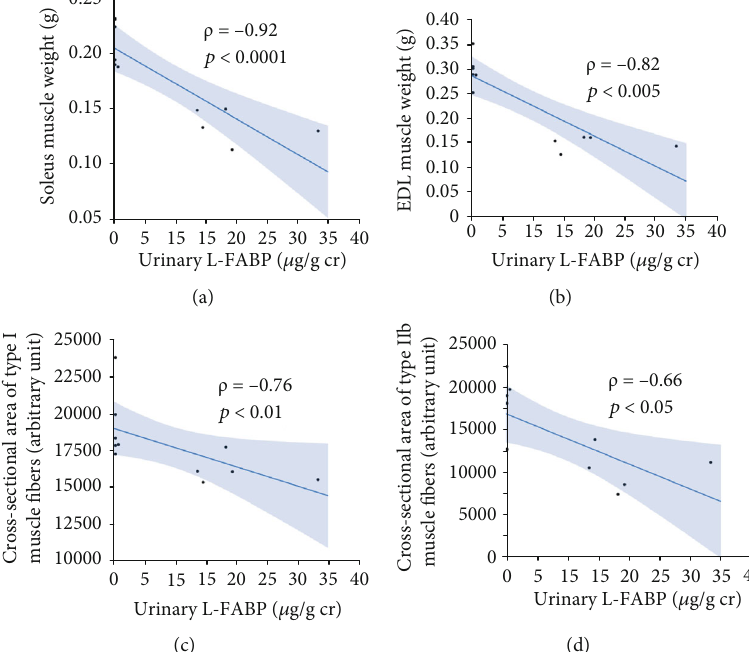
Figure 8: Correlations of urinary L-FABP with the weights of the soleus (a) and ELD muscles (b) and cross-sectional areas of type I (c) and IIb (d) muscle fi bers.